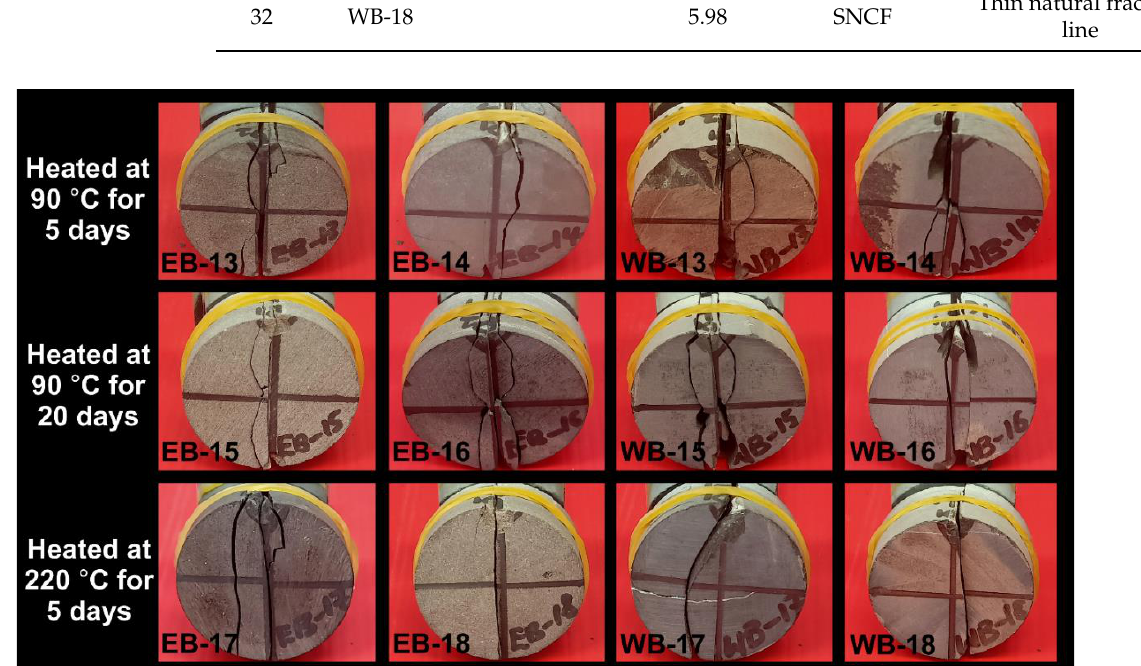
Figure 21. Image representation of tensile failure patterns resulting from Eagle Ford and Wolfcamp shale samples exposed to different heat treatment conditions prior to BITS testing.